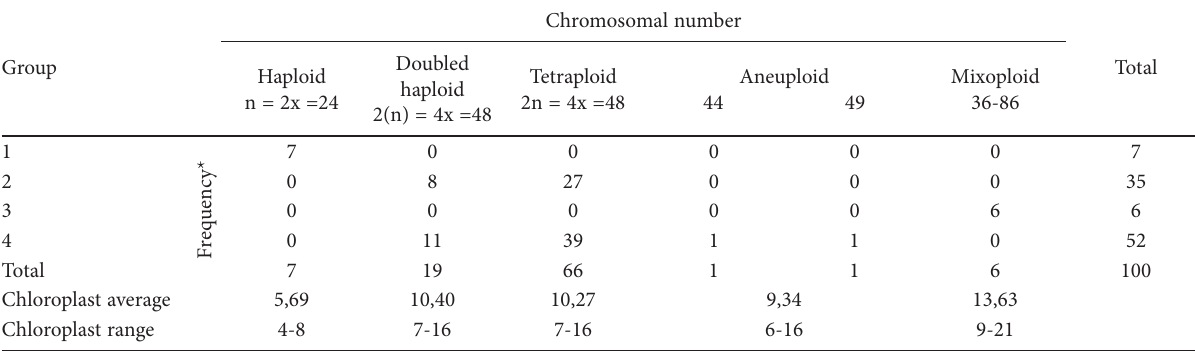
Table 1. Cluster analysis. Conformation of groups by chromosome number.